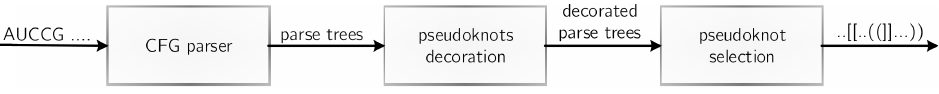
Figure 2. Tasks of the proposed methodology.